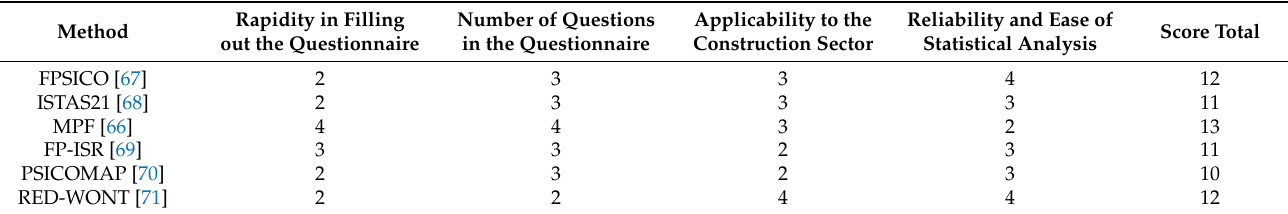
Table A1. Decision matrix for selecting the assessment methods.